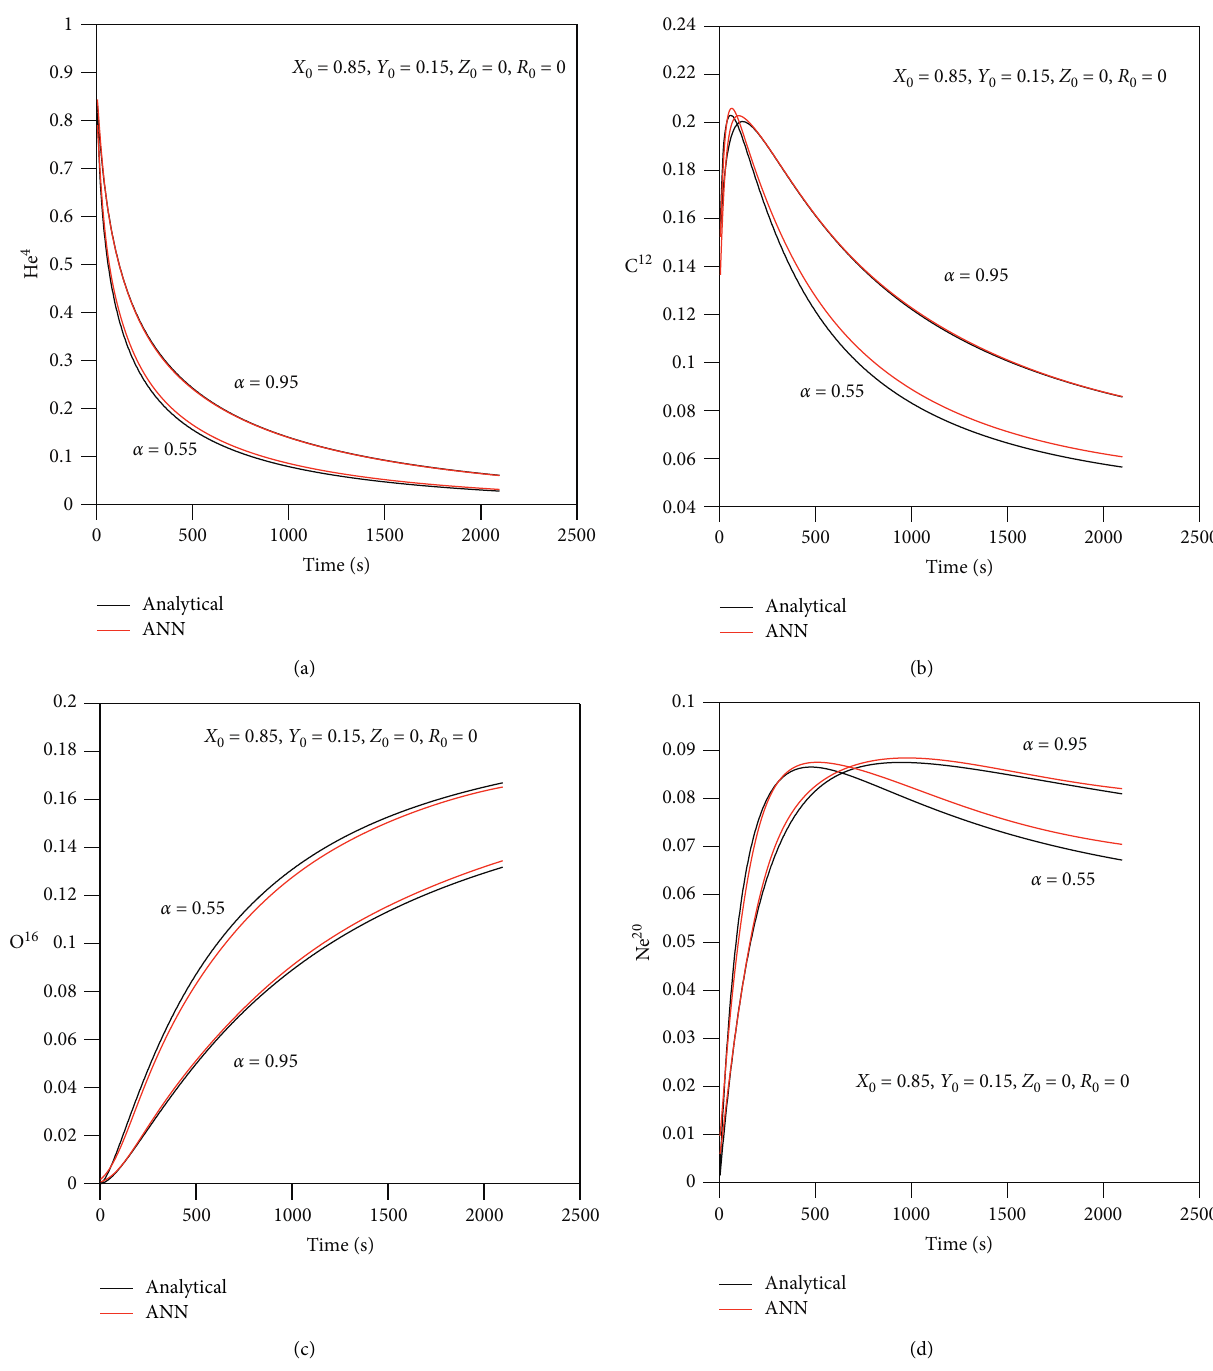
Figure 6: The distribution of the product abundance with time for the rich helium burning network, X R 0 �